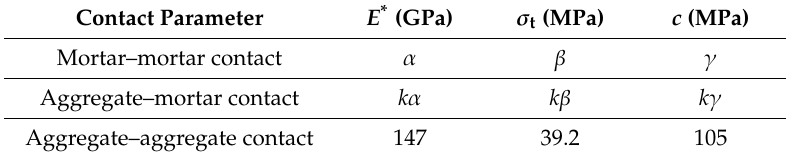
Table 4. Parameters of contacts in discrete element modeling of ordinary